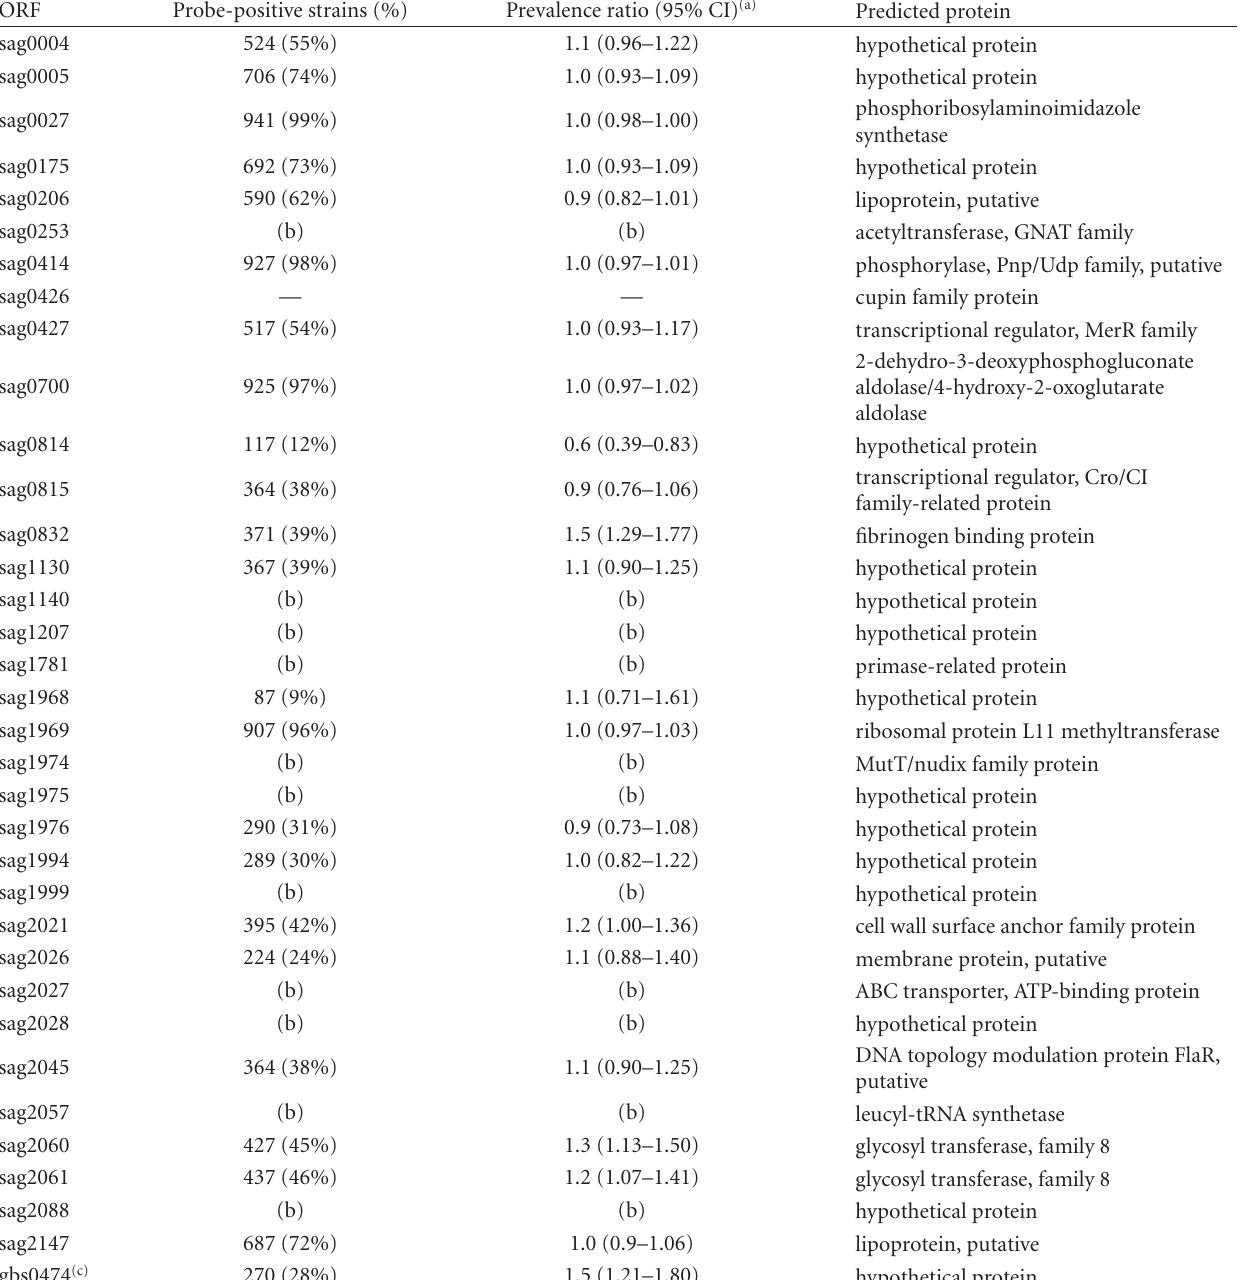
Table 3: Open reading frames (ORF) present in invasive strains but absent at least in two out of three commensal tester group B Streptococcus strains by comparative genomic hybridization and their presence among 949 GBS isolates and their prevalence ratio between invasive ( n = 386) and colonizing ( n = 563)